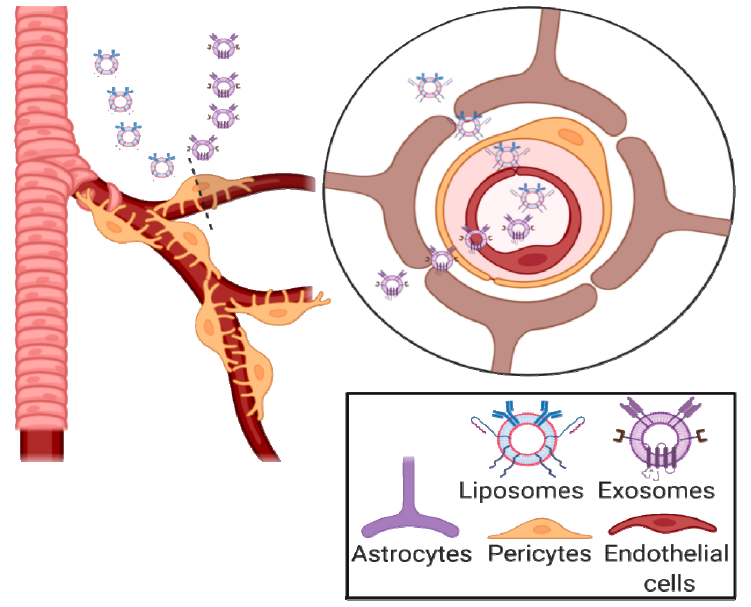
Figure 3. Schematic representation of liposomes, inorganic and polymeric nanoparticles crossing the BBB. Created with BioRender.com BBB. Created with